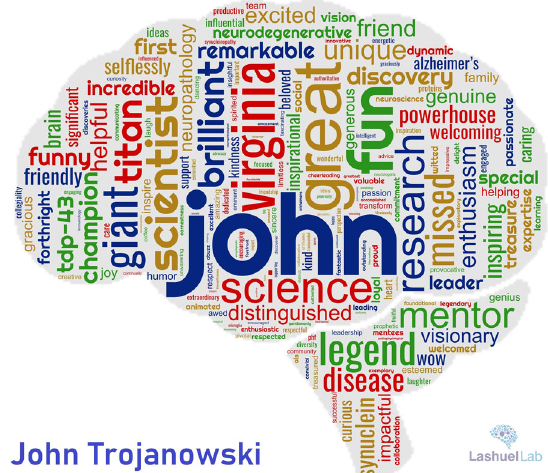
Fig. 3 John Q Trojanowski in the words of his colleagues and scientists from the fi eld of NDDs. A John Trojanowski word